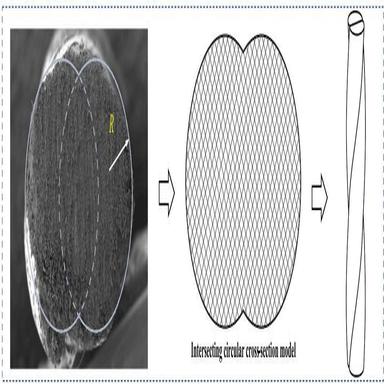
Schematic diagram of the helical carbon fiber tows cross-section and the proposed intersecting circular cross-section model.